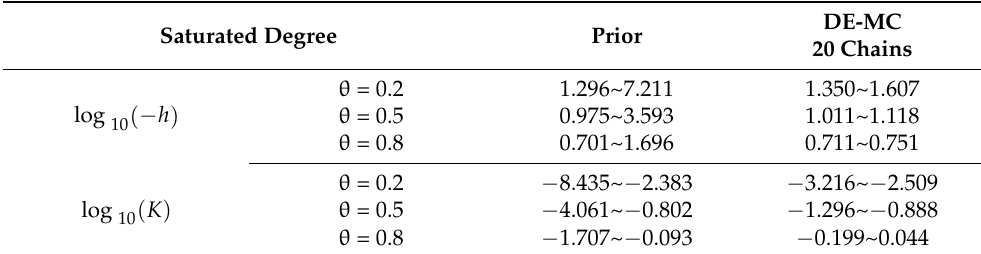
Figure 8. SWCC and HCF of real case example. Table 5. The ranges of logarithmic transformed pore water pressure head and hydraulic conductivity in the ensemble prediction of SWCC and HCF at specific saturated